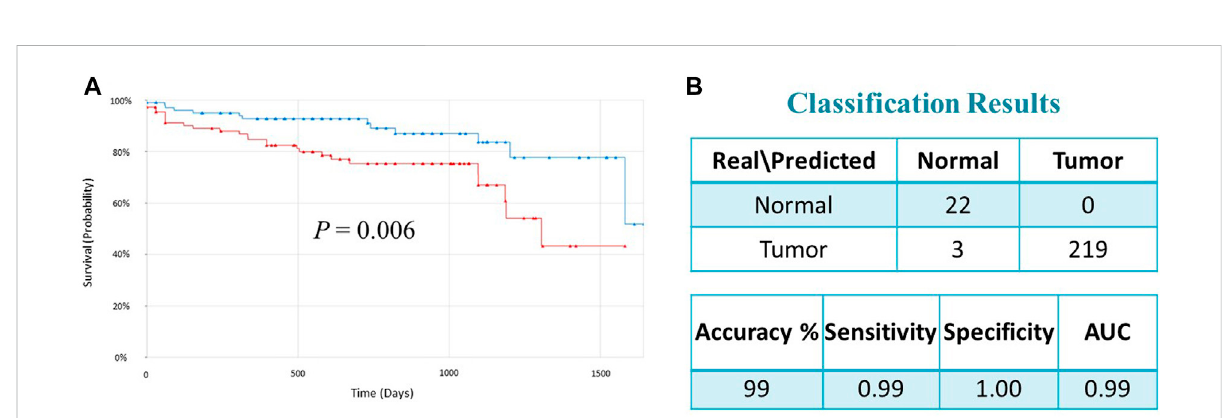
FIGURE 4 (A) Kaplan – Meier survival analysis of the TCGA dataset indicated that the high-risk group had signi fi cantly worse prognosis than the low-risk group ( p = 0.006). Red and green curves indicate high and low-risk groups, respectively. (B) Classi fi cation performance of the 17-gene classi fi er modeled using SVM with linear kernel algorithm. The classi fi cation performance is evaluated on the TCGA dataset ( n =